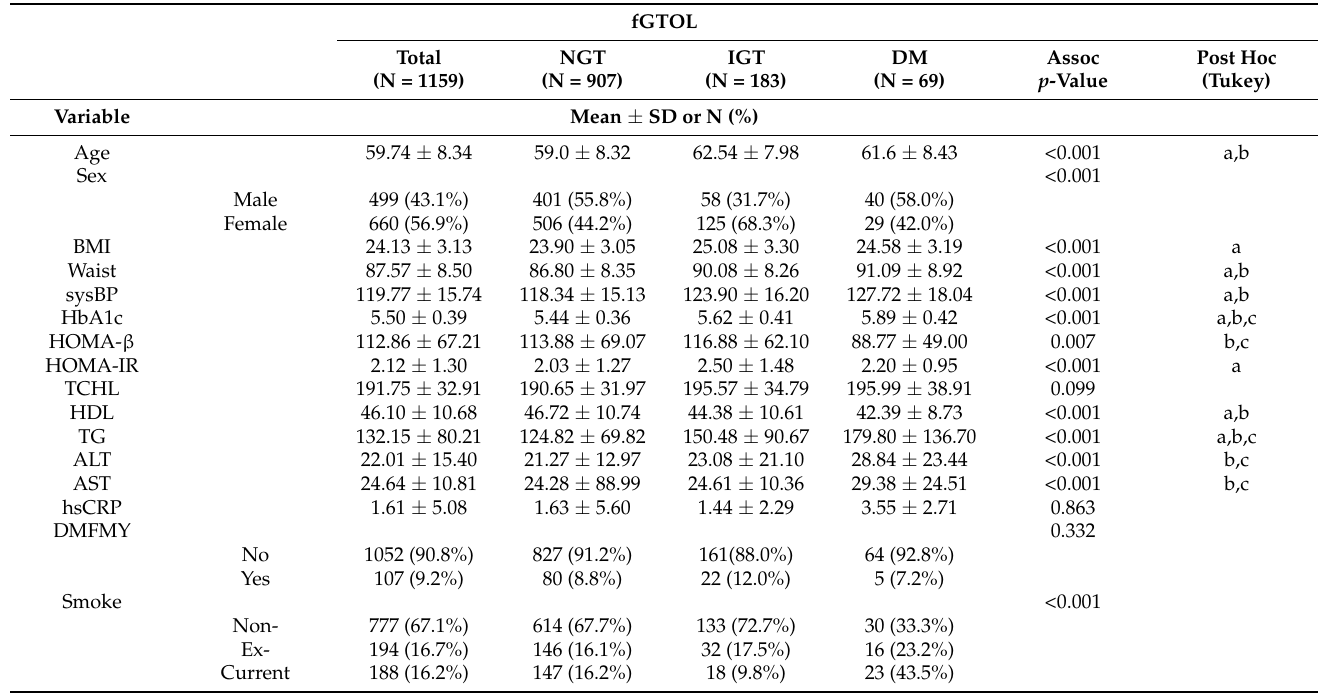
Table 2. Baseline characteristics of candidate predictor variables by fGTOL, the glucose tolerance status after 4 years